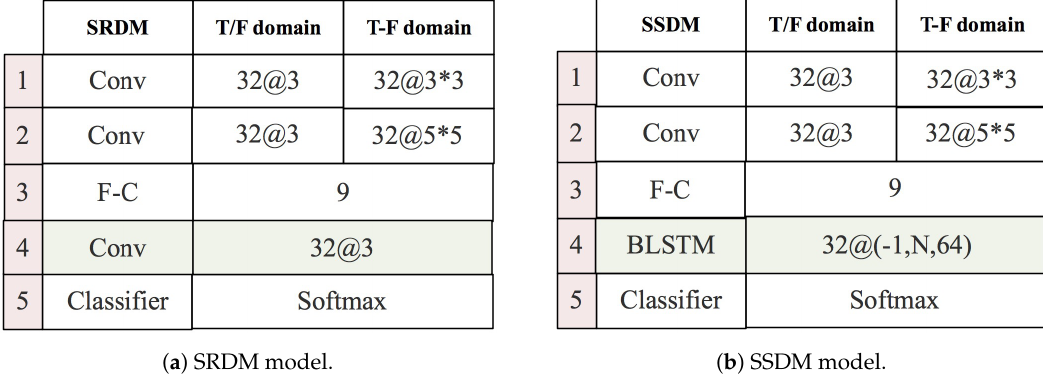
Figure 10. Two similar single-domain HRRP test